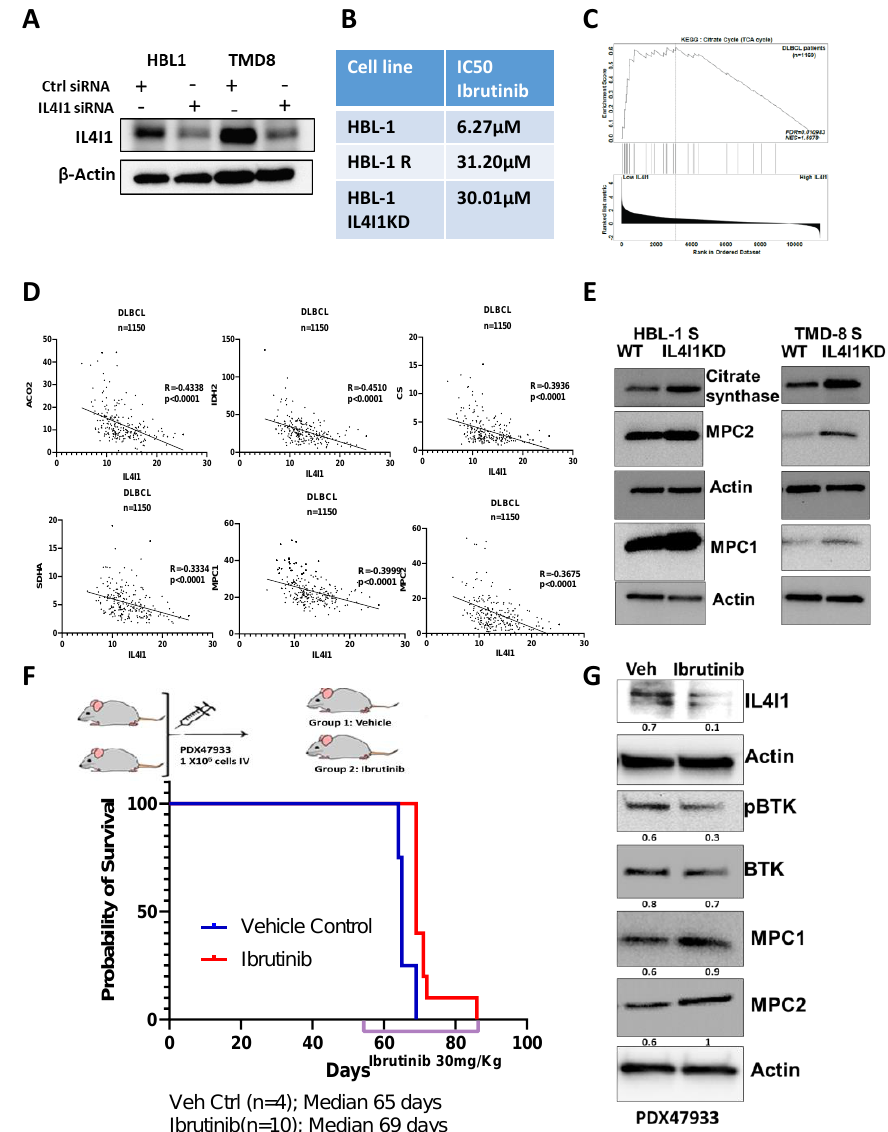
Figure 5. Loss of IL4I1 correlates with TCA cycle enzymes and mimics resistance to ibrutinib. ( A ) Western blot of baseline IL4I1 expression upon transfection by siRNA specific to IL4I1 or scrambled siRNA in HBL1 and TMD8 cells. ( B ) Table depicting IC50 concentrations of the HBL1 cells with either control or IL4I1 siRNA or HBL1-resistant lymphomas treated with ibrutinib (please note that the genetic manipulation alters the basal IC50 in resistant clones). ( C ) Low IL4I1 levels in ibrutinib-resistant ABC--DLBCL patients are enriched for TCA cycle enzymes as determined by GSEA on GSE93984. ( D ) Correlation plot of the IL4I1 with 1150 DLBCL patients. ( E ) Western blot analysis of TCA enzymes in HBL1 and TMD8 ibrutinib-sensitive cells transfected with IL4I1siRNA. ( F ) Kaplan – Meier curve demonstrating the survival of ibrutinib- treated ABC- DLBCL PDX in NSG mice. ( G ) Western blot analyses on isolated pooled splenocytes from the vehicle control or ibrutinib-treated ABC-DLBCL patient-derived xenograft and probed for the labeled antibodies (values below blots rep- resent relative densitometry quantification value compared to actin).